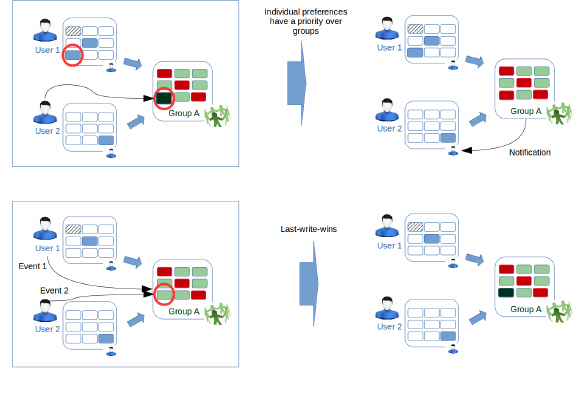
Figure 9. Conflicts